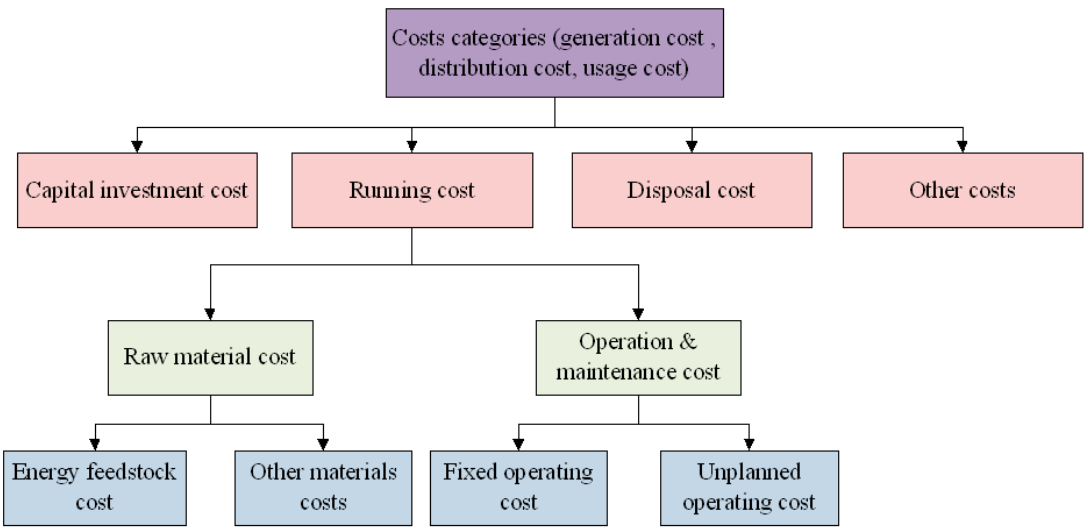
Figure 3. The major cost categories for life cycle costing analysis. Table 2. Technical data and parameters for life cycle analysis for economic data identifications.